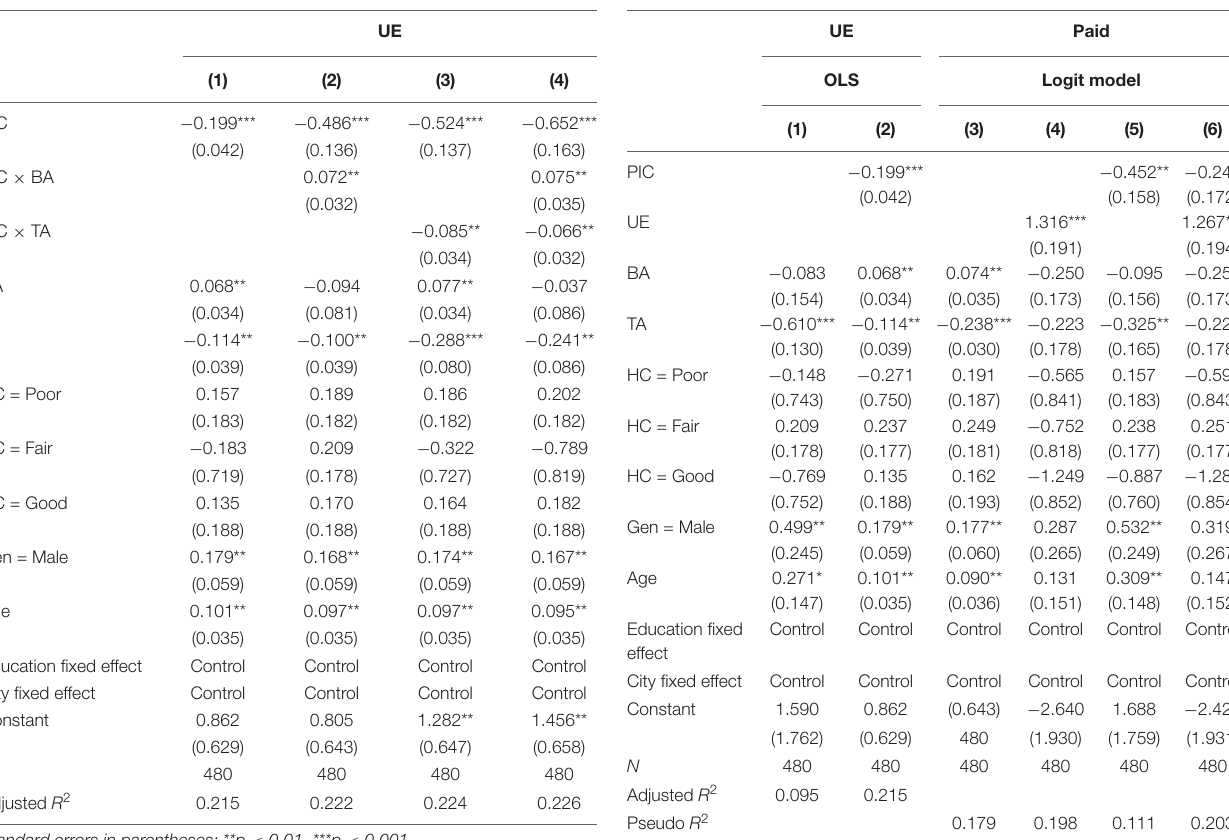
TABLE 4 | Results of the moderating effects. TABLE 5 | Results of the main and mediating